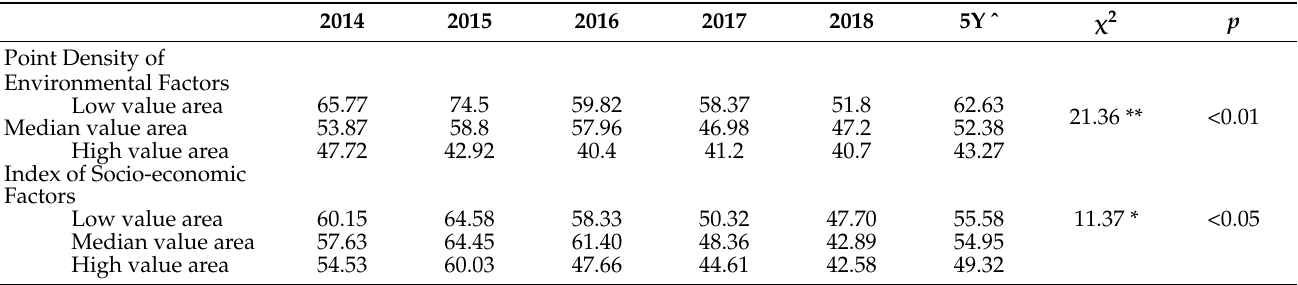
Table 3. GIR in different groups of counties in the HRB classified by the point density of environmental factors and index of socioeconomic factors from 2014 to 2018.